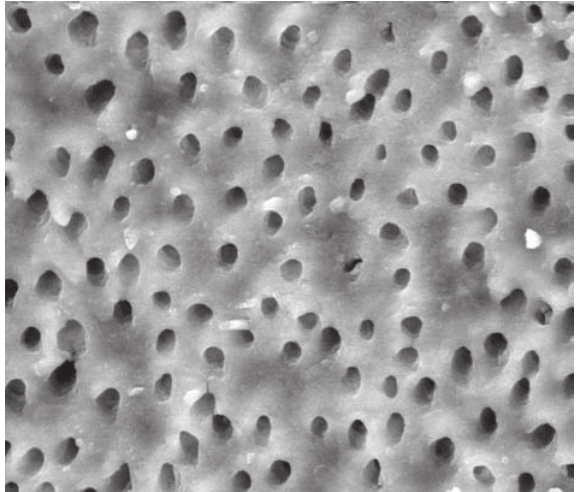
Figure 2- Scanning Electron Microscopy (SEM) micrograph of the smear layer in root canals irrigated with distilled water. No dentinal tubules are visible because of the smear layer covering the root canal